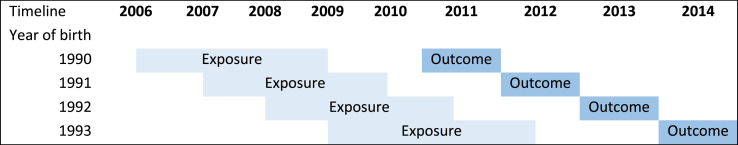
Timeline for the study, with point of measurement of exposure, OPMH service use, and outcome, upper-secondary school completion, for each of age cohorts.